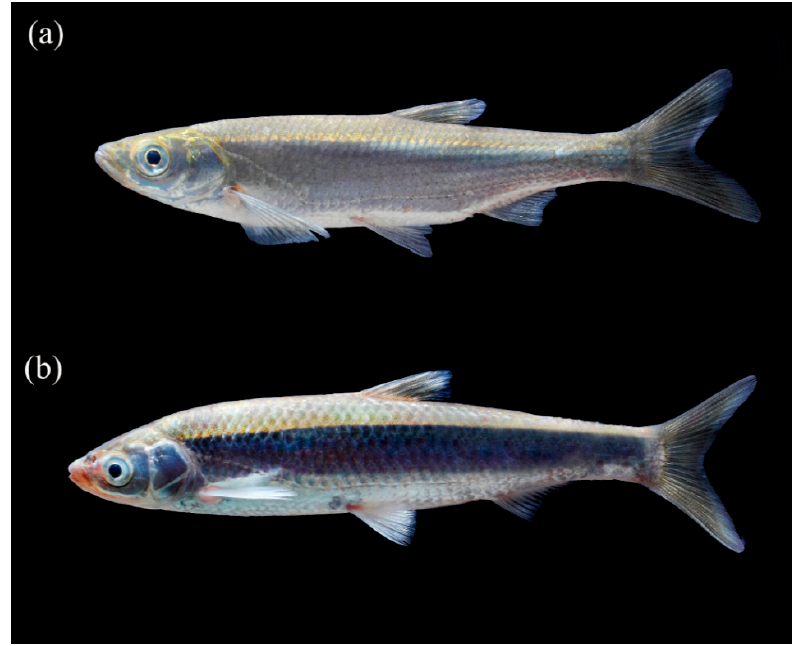
Figure 3. Photos of the studied species, Hemiculter leucisculus ( a ) and Hemiculter bleekeri ( b ).